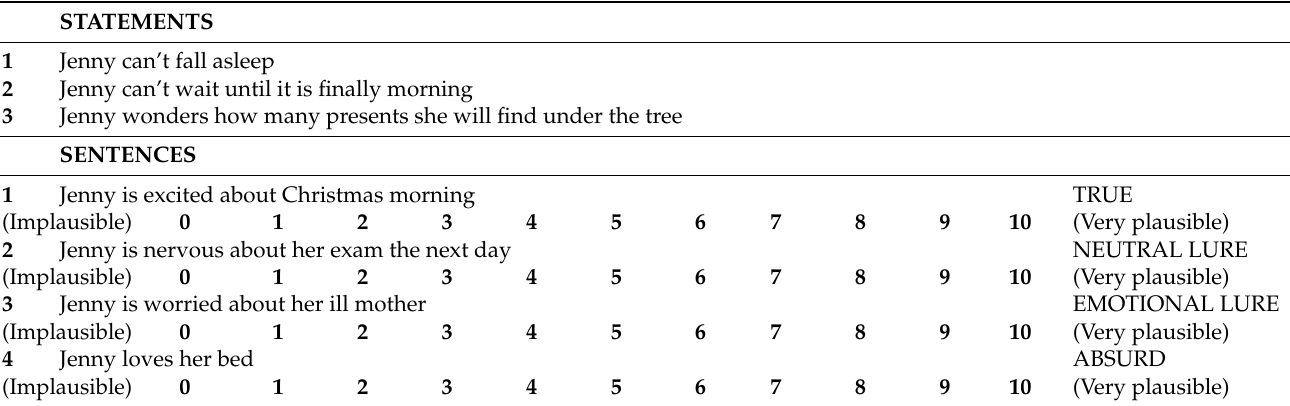
Table 1. Example trial of the BADE task.